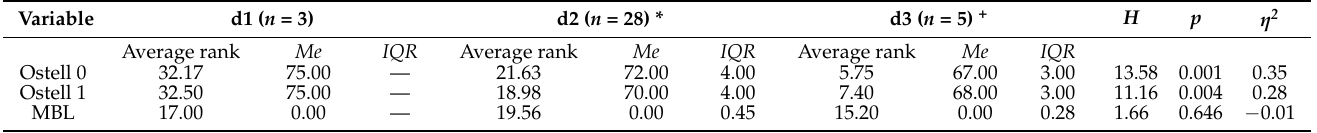
Table 5. Kruskal–Wallis test results for Ostell and MBL variables.